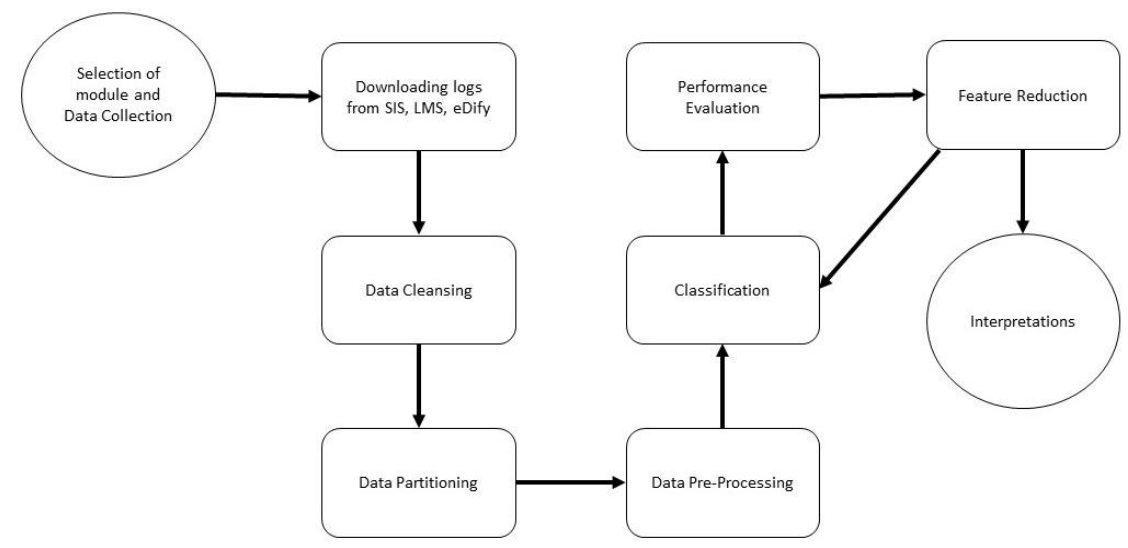
Figure 3. The cycle of applying educational data mining in research.